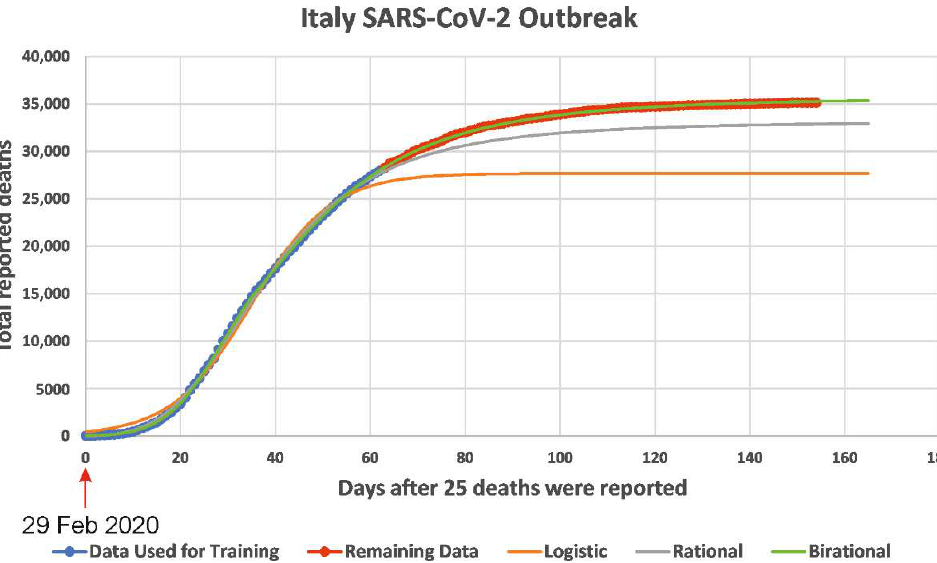
Figure 1. Predictions for the number of deaths in Italy. Comparison of the predictions of researchers’ formulae for the number of reported deaths using data only until 1 May 2020, versus the actual data until 1 August 2020 (predictions for 92 days). The thick blue data-points depict the data used for calibrating the formulae and the red data-points depict the data used for checking the predictions of the 3 formulae.